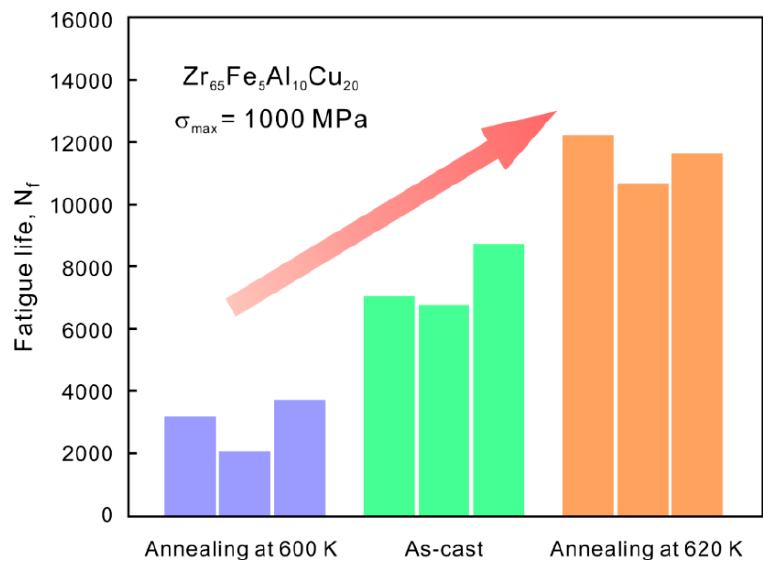
Figure 13. Fatigue life of the as-cast and annealed samples under σ max = 1000 MPa [53].